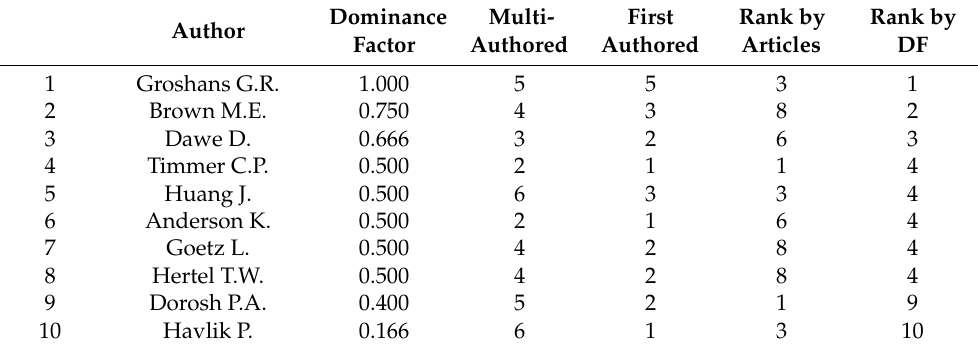
Table 5. The dominance of